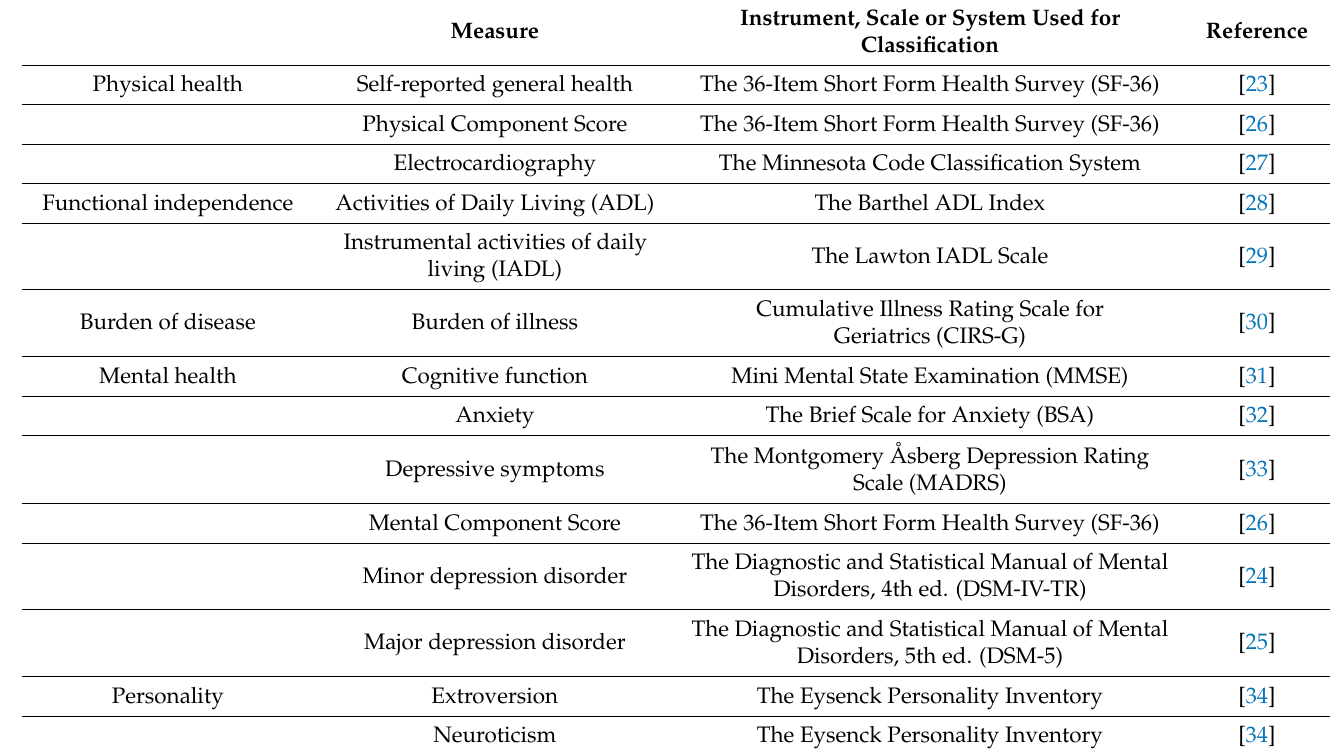
Table 2. Detailed information on instrument, scales and system used for measurement of health status. Instrument, Scale or System Used for Measure Classification